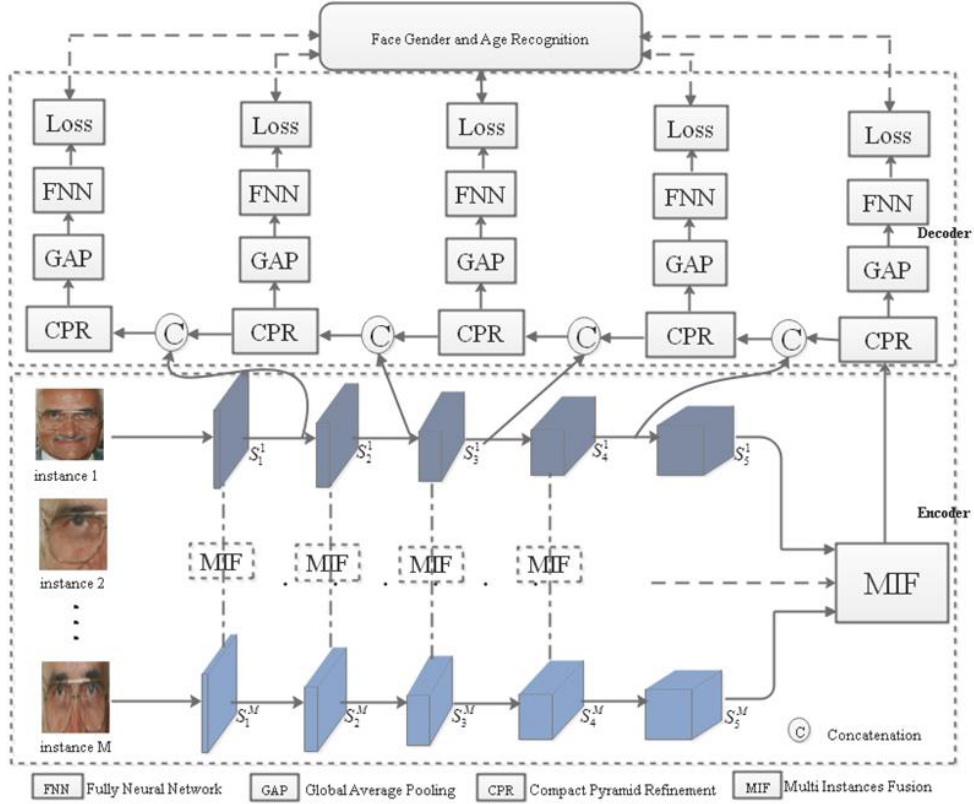
Figure 4. Multi-instance multi-scale fusion learning network.